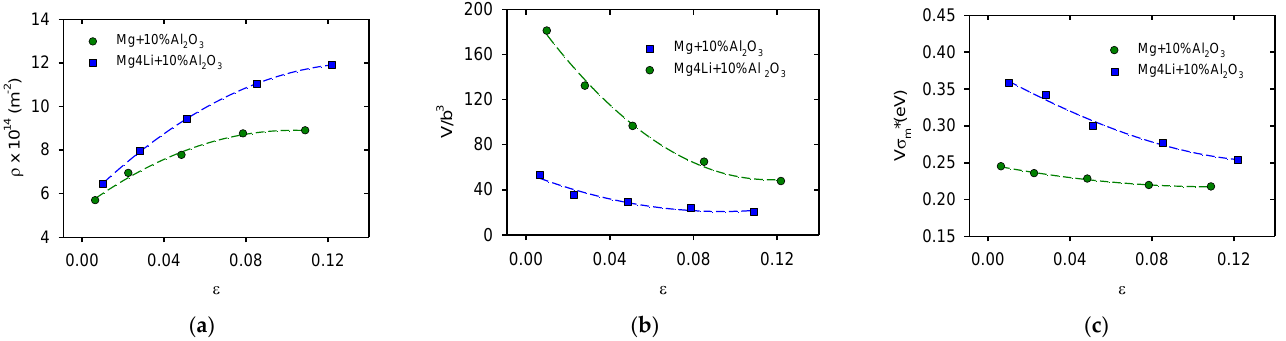
Figure 7. Calculated dislocation density, ρ ( a ); activation volume, V / b 3 ( b ); and V σ ∗ m product ( c ) vs. strain ε estimated for the Mg and Mg4Li composites.